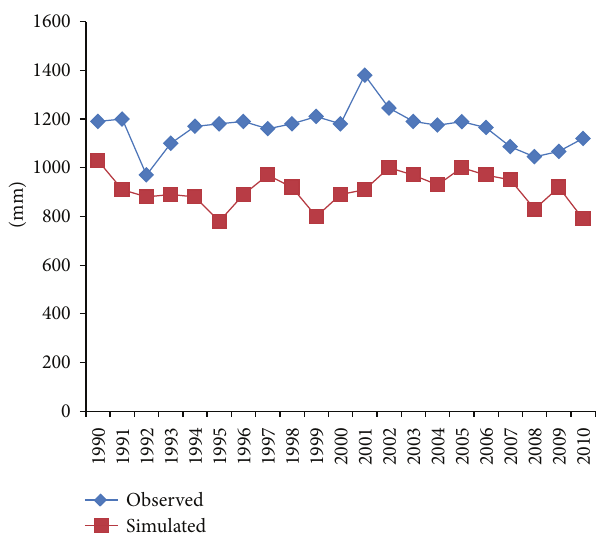
Figure 4: Comparison between the observed annual precipitation and simulated annual precipitation with the WRF model in Yunnan province during